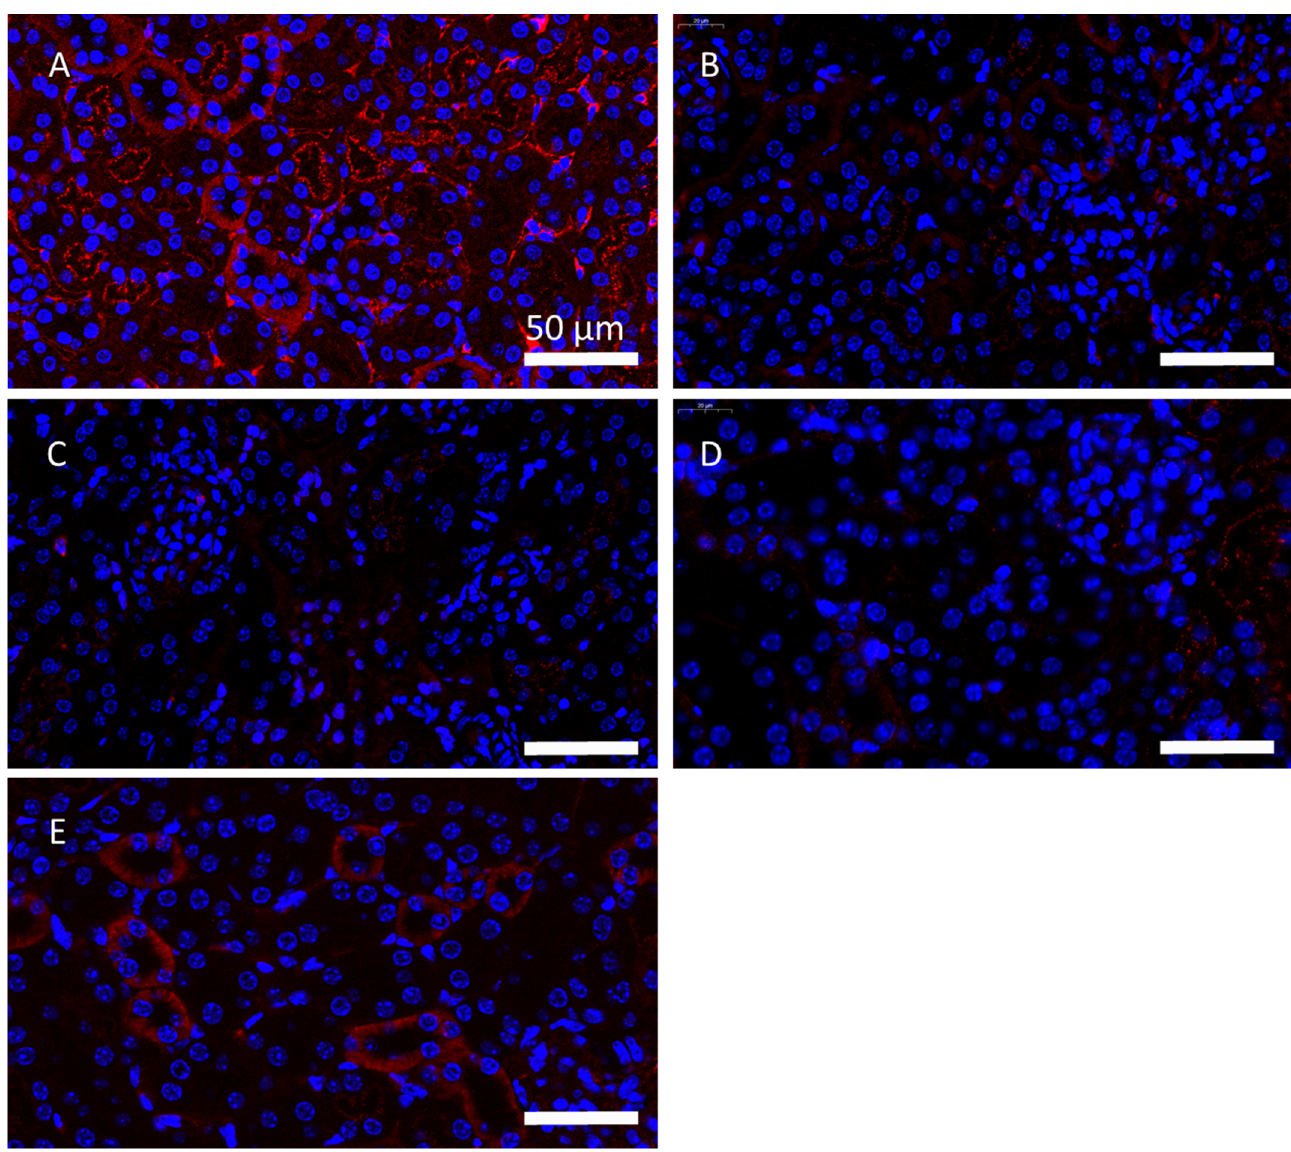
Figure 6. Renal immune complex examination. ( A ). Model group; ( B ). CTR-nanoflower-treated group; ( C ). IRS-661-nanoflower-treated group; ( D ). IRS-869-nanoflower-treated group; ( E ). IRS-954- nanoflower-treated group. Scale bar: 50 μ m.